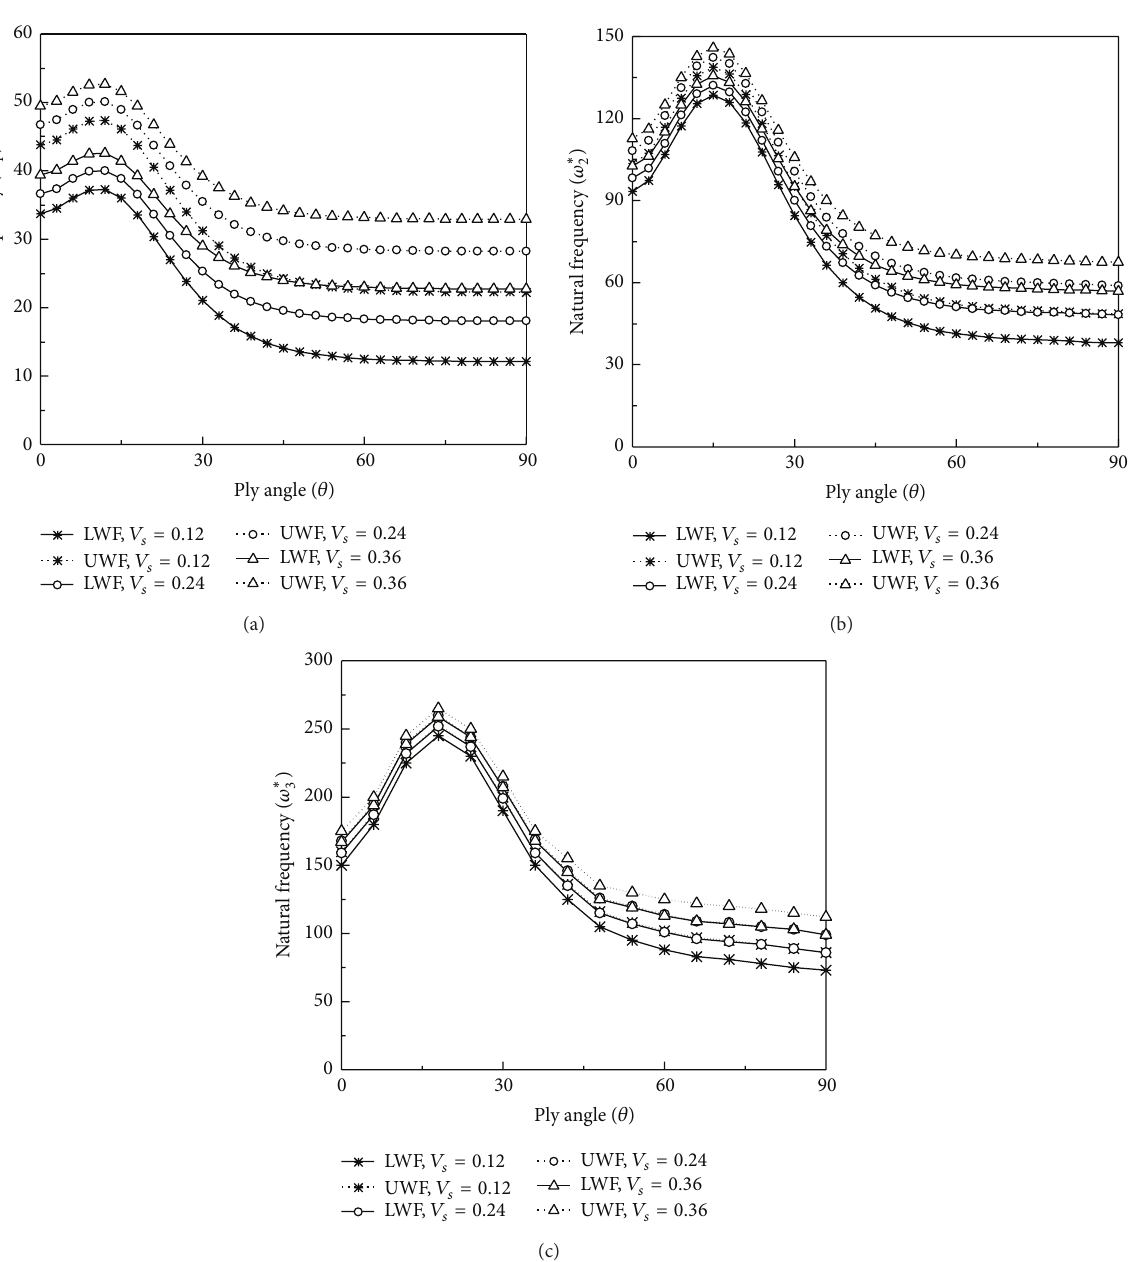
Figure 5: The first three natural frequencies versus ply-angle for different SMA wire fractions ( Ω ∗ = 5 rad/s; 𝑇 = 50 ∘ C; 𝜀 0 = 0.067 ).